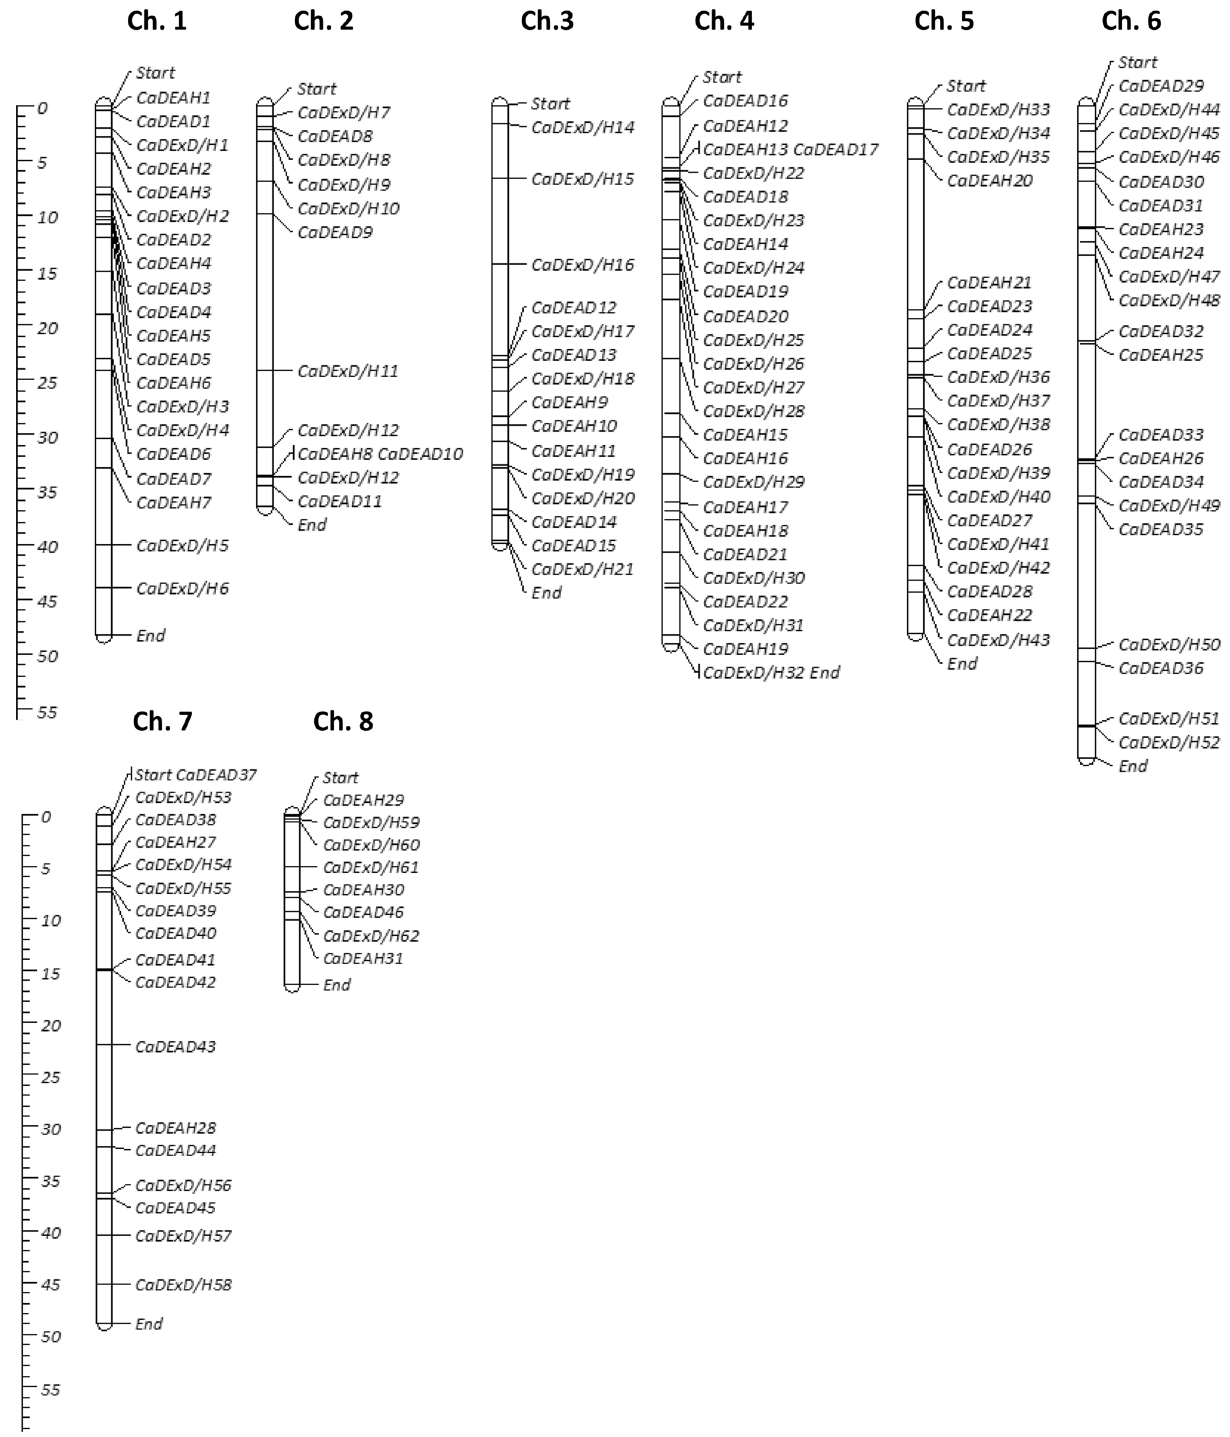
Figure 1. The distribution of the RNA helicase genes (139 in number) across the eight chickpea chromosomes. The genes were mapped as per the physical location (in Mega bases, Mb) on the chromosomes and the gene name is indicated on the right side of each bar. The scale on the left is in Mb. Eleven genes which were mapped on the unplaced scaffolds are not shown